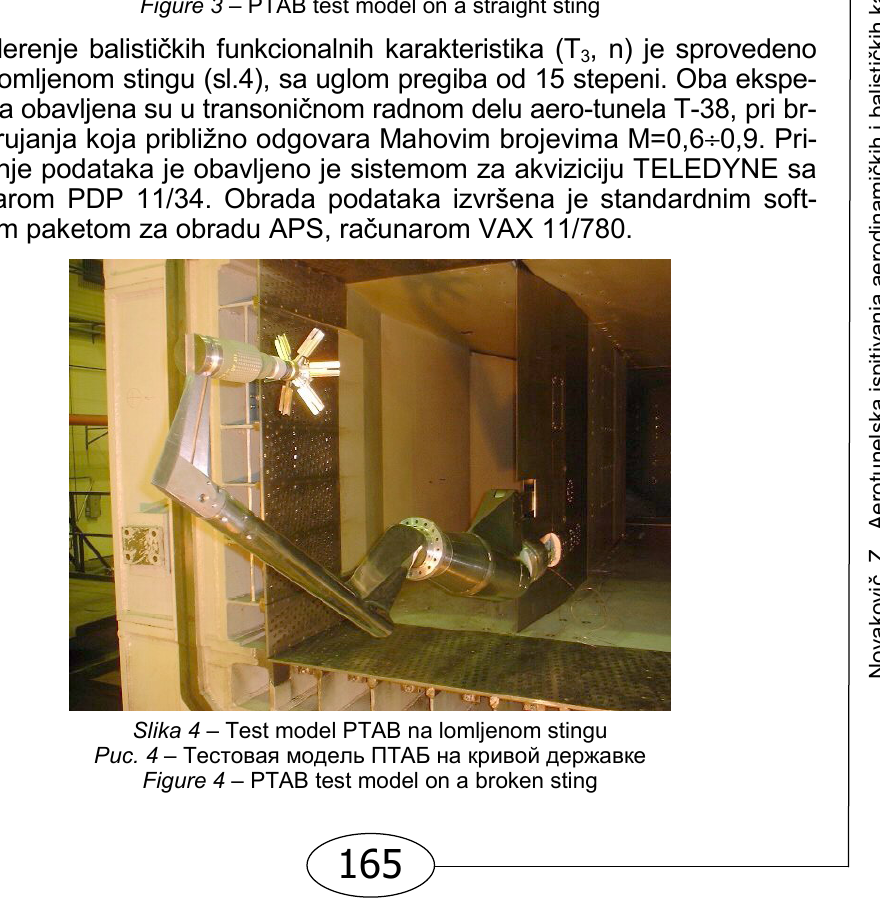
Figure 3 – PTAB test model on a straight sting